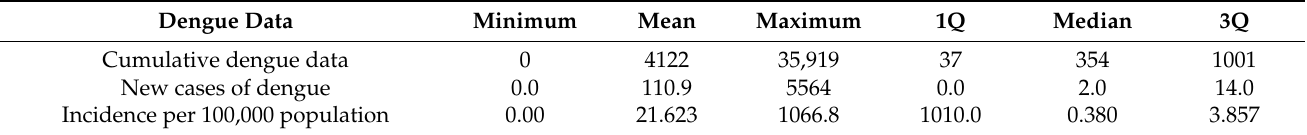
Table 1. Summary statistics of weekly dengue fever data from 2014 to 2020 in Asuncion,